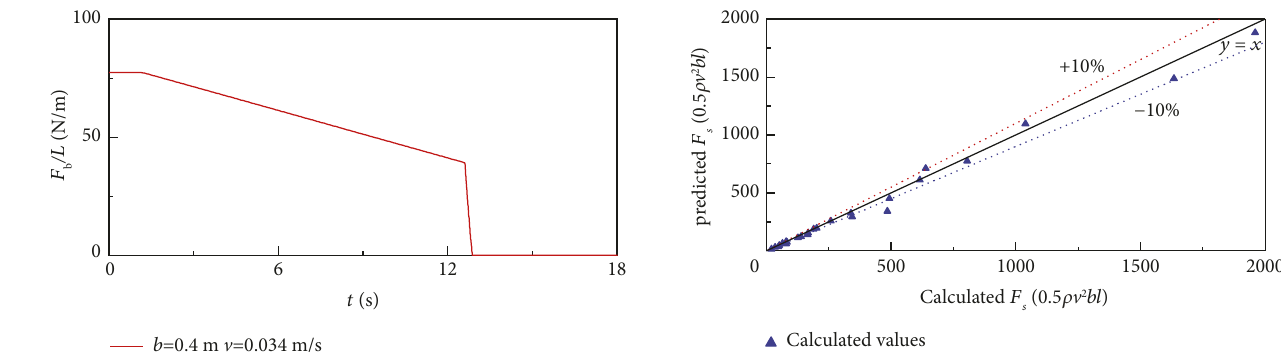
Figure 17: Calculated versus predicted normalized suction